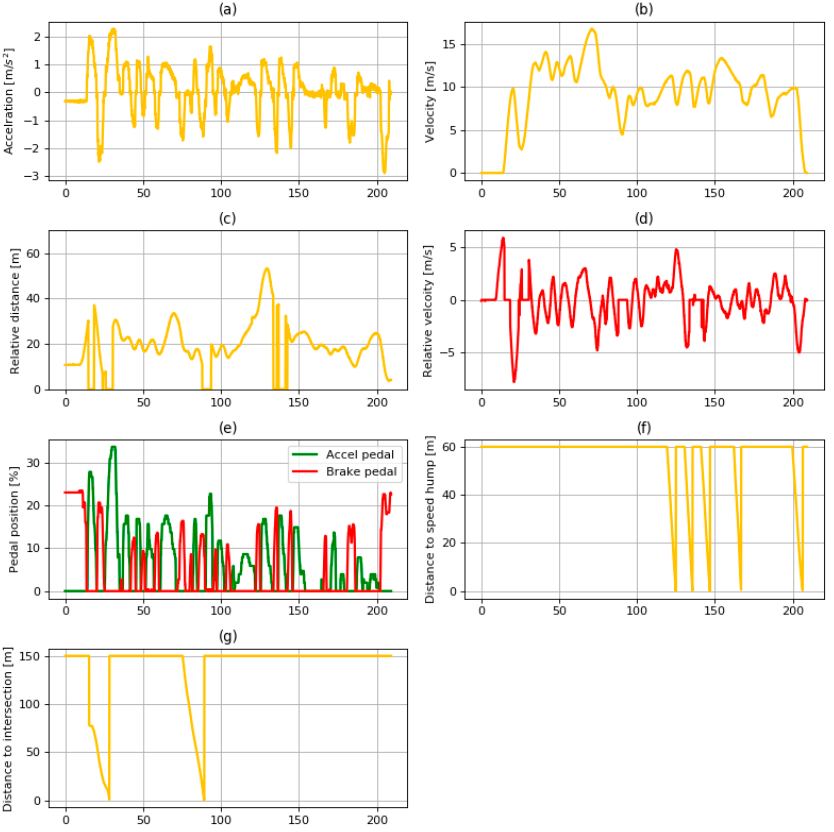
Figure 14. Data of ( a ) acceleration; ( b ) velocity; ( c ) relative distance; ( d ) relative velocity; ( e ) pedal position; ( f ) distance to speed hump; ( g ) and distance to intersection used in driving simulation.